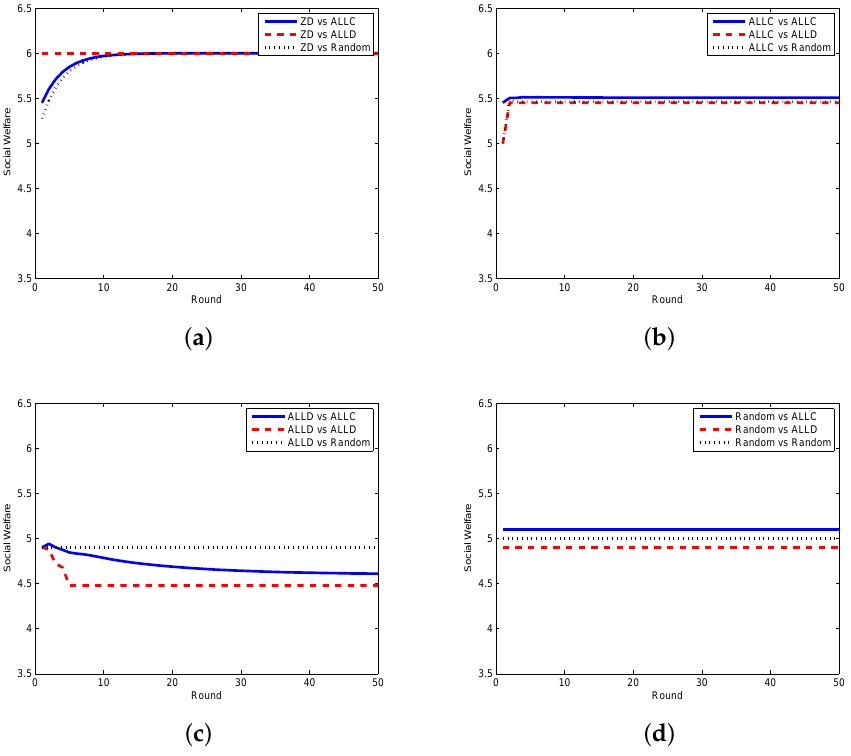
Figure 6. Social welfare with different strategy pairs (requestor vs. worker) among ZD, ALLC, ALLD, and Random in the continuous model. ( a ) requestor adopts the ZD strategy; ( b ) requestor adopts the ALLC strategy; ( c ) requestor adopts the ALLD strategy; ( d ) requestor adopts the Random strategy.